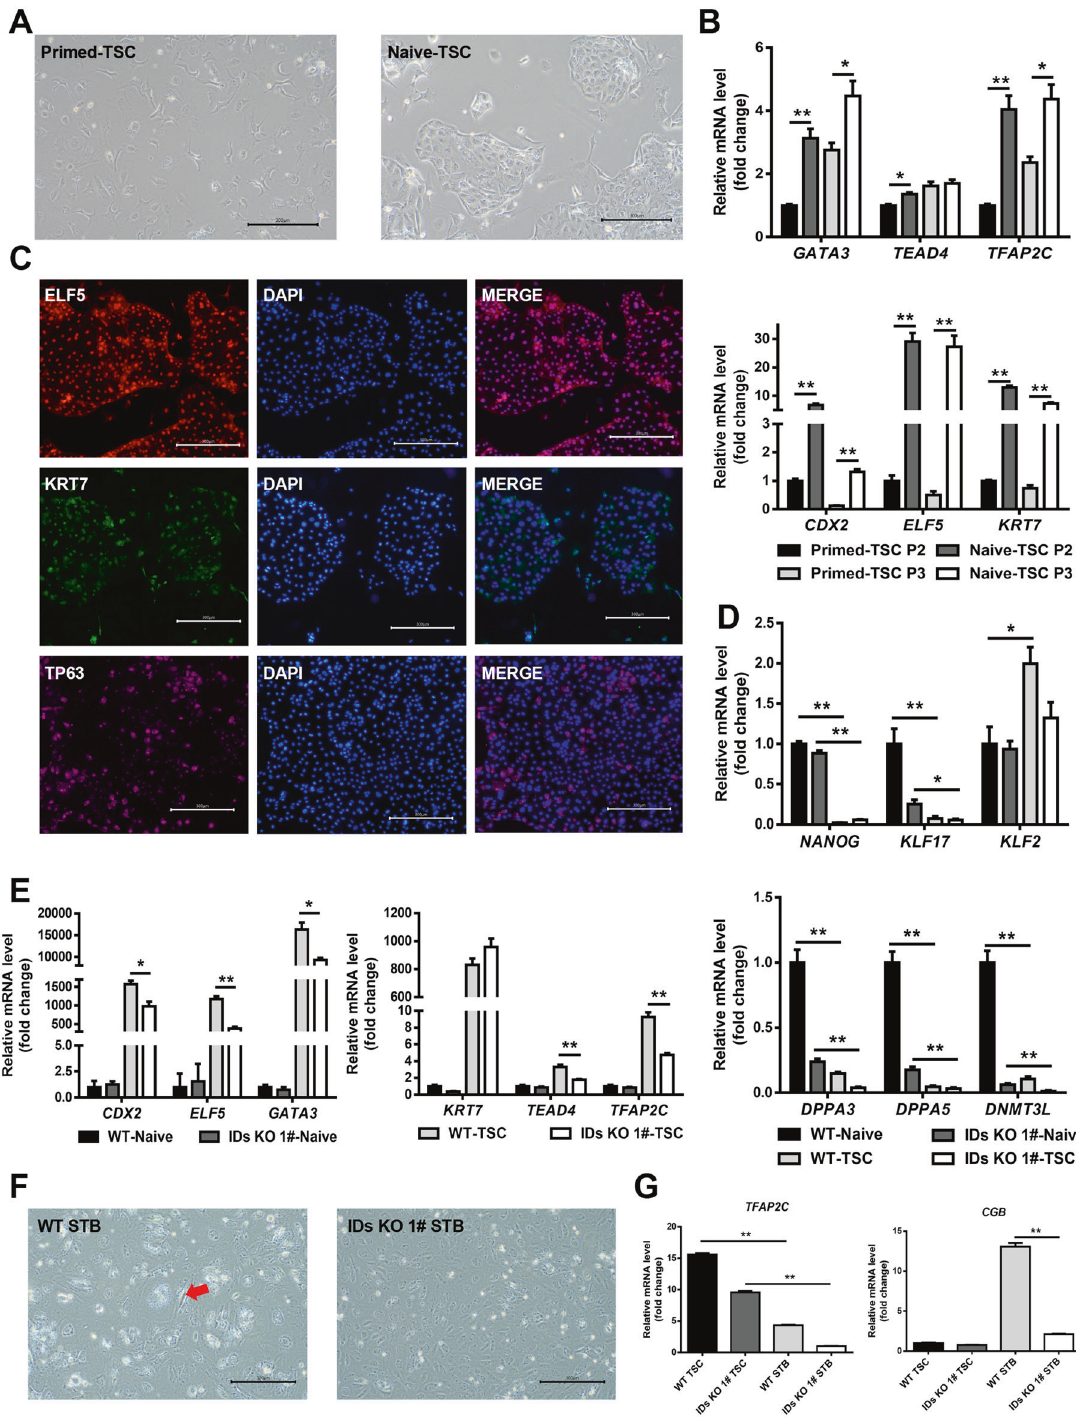
Fig. 3 ID1 and ID3 double knockout attenuates the TSC-differentiation potential of naive hESCs. A Morphology of trophoblast stem cell that are derived from primed and naive state hESCs separately, bar = 300 μ m. B Quantitative gene expression analysis for the trophoblast marker genes ELF5 , KRT7 , GATA3 , TFAP2C , TEAD4 ,and CDX2 in the H9 hTSC-like cells derived from naive hESCs, and primed hESCs cultured in hTSC medium ( n = 3), data are presented as means ± SEM, t -test, * p < 0.05; ** p < 0.01. C Immuno fl uorescence staining for TSC markers KRT7, ELF5, and TP63 in H9 hTSC-like cells derived from naive hPSCs. The scale bars indicate 300 μ m. D The naive state associated genes expression level of naive hESCs and TSC that derived from WT and double knockout lines separately ( n = 3), * p < 0.05; ** p < 0.01, compared with WT, data are presented as means ± SEM, one-way ANOVA followed by t -test. E The TSC associated genes expression level of naive hESCs and TSCs that derived from WT and double knockout lines separately ( n = 3), * p < 0.05; ** p < 0.01, compared with WT, data are presented as means ± SEM, one-way ANOVA followed by t -test. F Morphology of 2D- syncytiotrophoblast that are derived from WT and double knockout lines TSC separately, bar = 300 μ m. G qPCR detect the TFAP2C and CGB gene expression level of TSCs and STB that derived from WT and double knockout lines separately, * p < 0.05; ** p < 0.01, compared with WT, data are presented as means ± SEM, t -test.